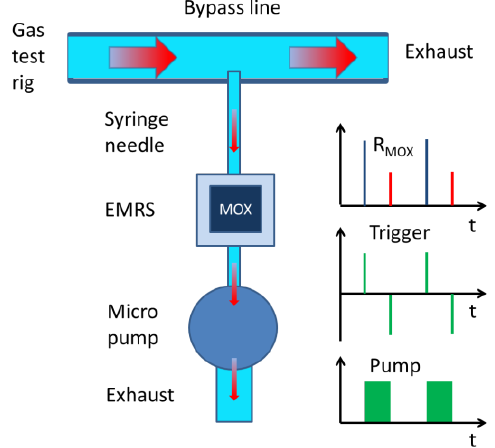
Figure 5. EMRS gas detection architecture. Synthetic air with analyte gases are dosed into the bypass line. The EMRS is fed with gas samples through pump-enforced gas streams. MOX resistances are read out during pump-on and pump-off trigger pulses and stored for later evaluation.